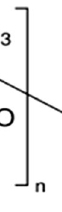
Fig. 1 Structure of polymethyl-